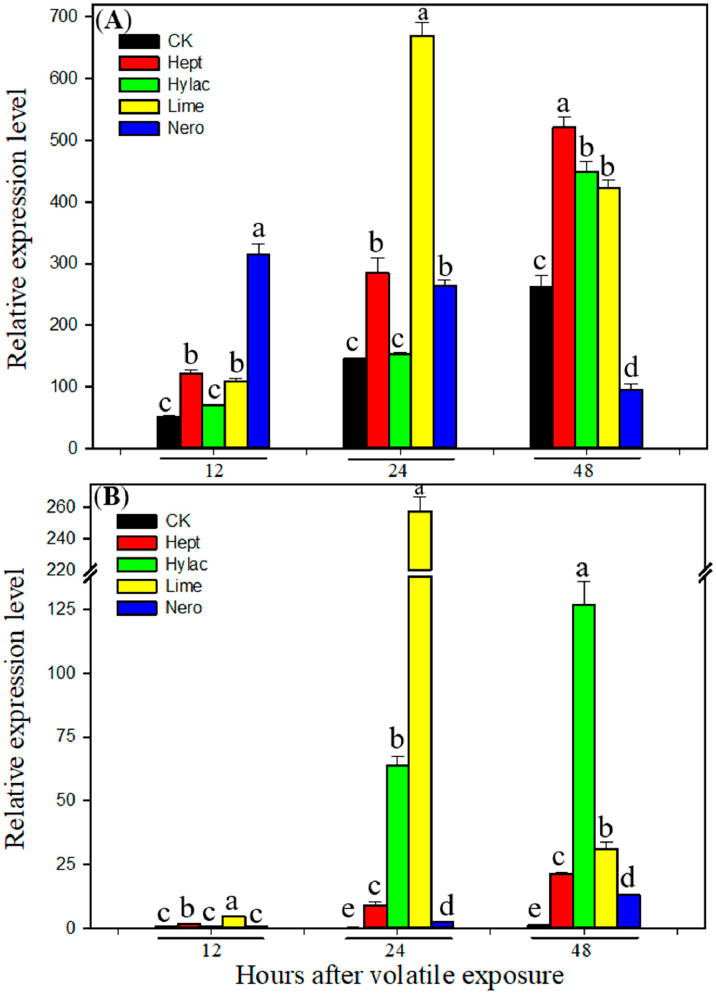
Figure 4. Transcript levels of CYP6B7 in midguts ( A ) and fat bodies ( B ) of fifth instar larvae of Helicoverpa armigera exposed to plant volatiles. Newly molted fifth instars were individually exposed to volatile 2-heptanone (Hept), cis- 3-hexenyl acetate (Hylac), limonene (Limo) and nerolidol (Nero) at a dose of 1 µL per cup for 12, 24 or 48 h, respectively in a sealed cup. Then the midguts and fat bodies were dissected. Total RNA was pooled from midguts or fat bodies of 20 fifth instar H. armigera larvae exposed to different plant volatile for 12, 24 and 48 h. Control larvae (CK) were fed with diet without plant volatile. Real-time qRT-PCR analysis was conducted to determine the relative transcript levels of the gene. Data shown are means ± SE derived from three biological repeats ( n = 3). Different letters above bars indicate significant differences ( p < 0.05 using ANOVA followed by a Tukey test for post-hoc comparison).